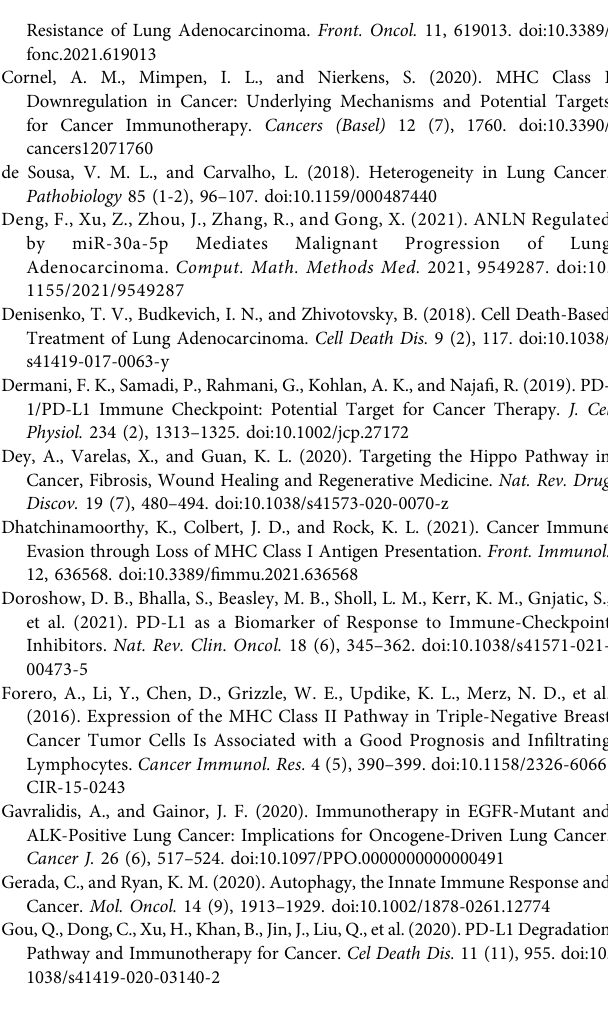
Supplementary Figure S1 | Heatmap of DEGs in TEAD4 -high vs. TEAD4 -low groups. Supplementary Figure S2 | Validation of the Cox model with GEO data. (A – C) Overall survival of high- and low-risk groups, respectively, in GEO validation set#1 (A) , validation set#2 (B) , and validation set#3 (C) . (D – F) ROC analyses of the model for 1, 3, and 5 years, respectively, in GEO validation set#1 (D) , validation set#2 (E) , and validation set#3 (F)